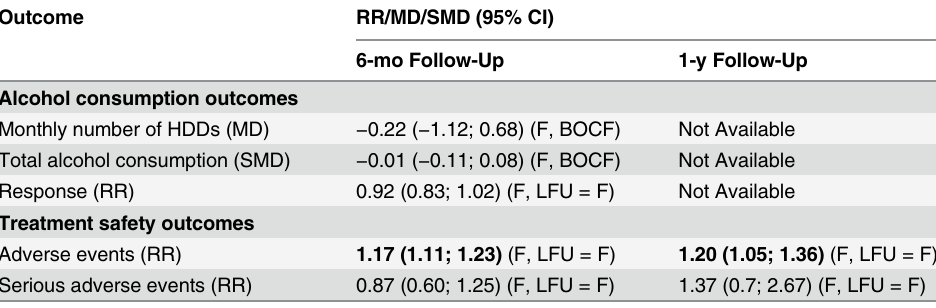
Table 4. Summary of findings from sensitivity analyses using conservative approaches to managing withdrawals from the